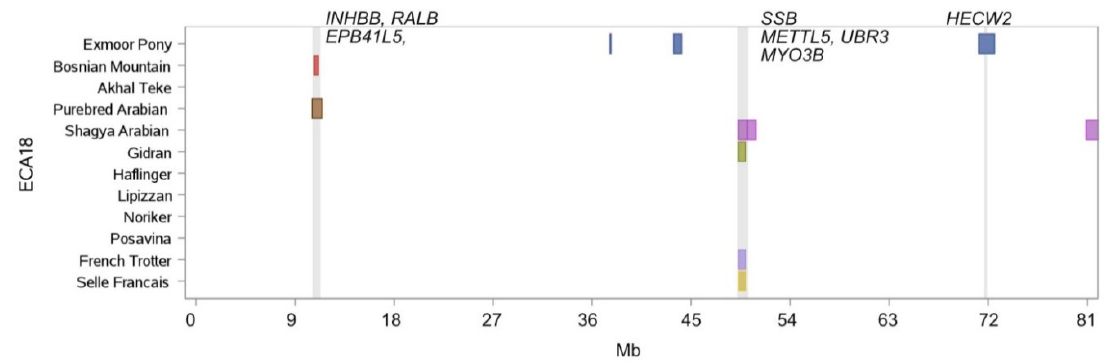
Figure 8. ROH islands on ECA18 between 1 Mb and 81 Mb. Location and length of ROH islands (shared by more than 50% of individuals per breed) per breed are illustrated as horizontal boxes, location of genes of specific interest are indicated as vertical lines.